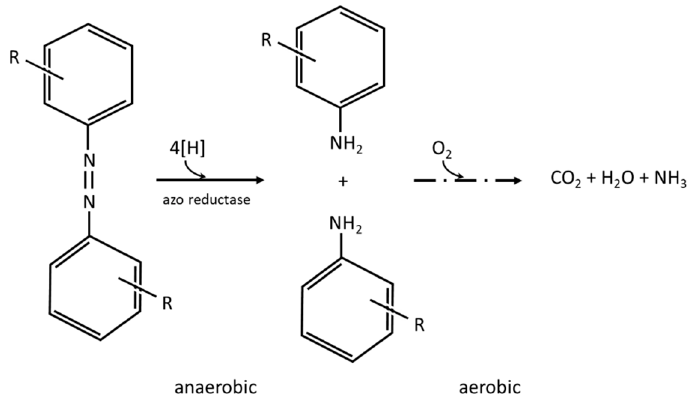
Figure 2. Scheme of azo dyes degradation in two step anaerobic ‐ aerobic treatment.